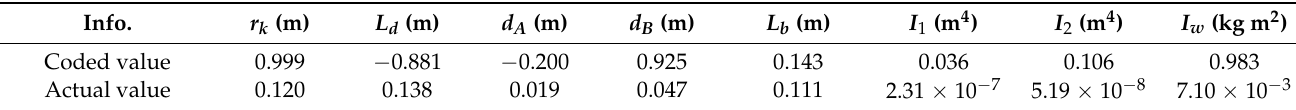
Table 10. The optimized values of the landing gear parameters.